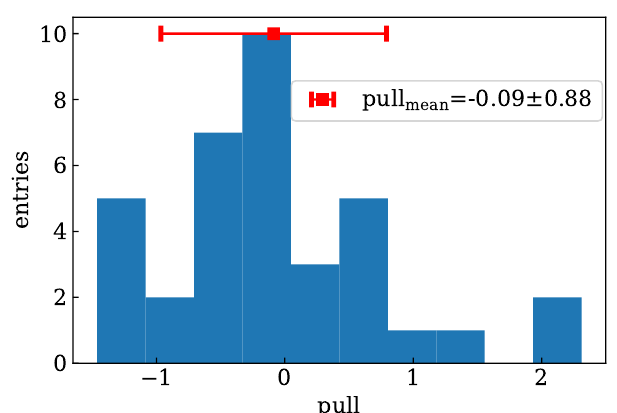
Figure 13. Histogrammed pull for calibrated energy deposition in silicon. The mean of the distribu- tion and the corresponding standard deviation are highlighted in red.